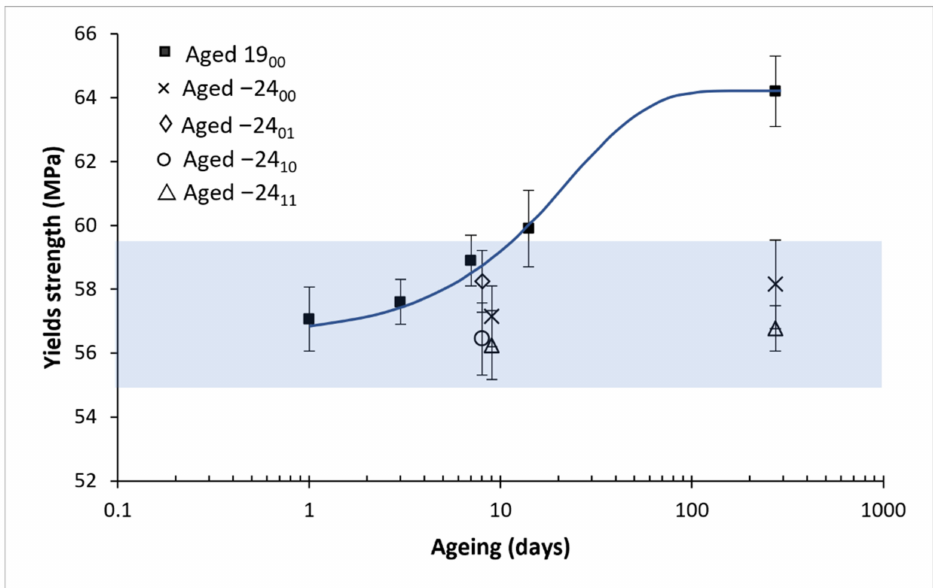
Figure 8. The average value of the yield strength with its mean square error. The reference material aged at room temperature is with bold marks and with its logistic fitting (line); empty symbols are from frozen and defrosted materials. For better visualisation, samples aged 9 days are separated in 8 and 9 days in the graph, but all do correspond with 9 days. Six samples were measured for each ageing conditions and error bars are the standard